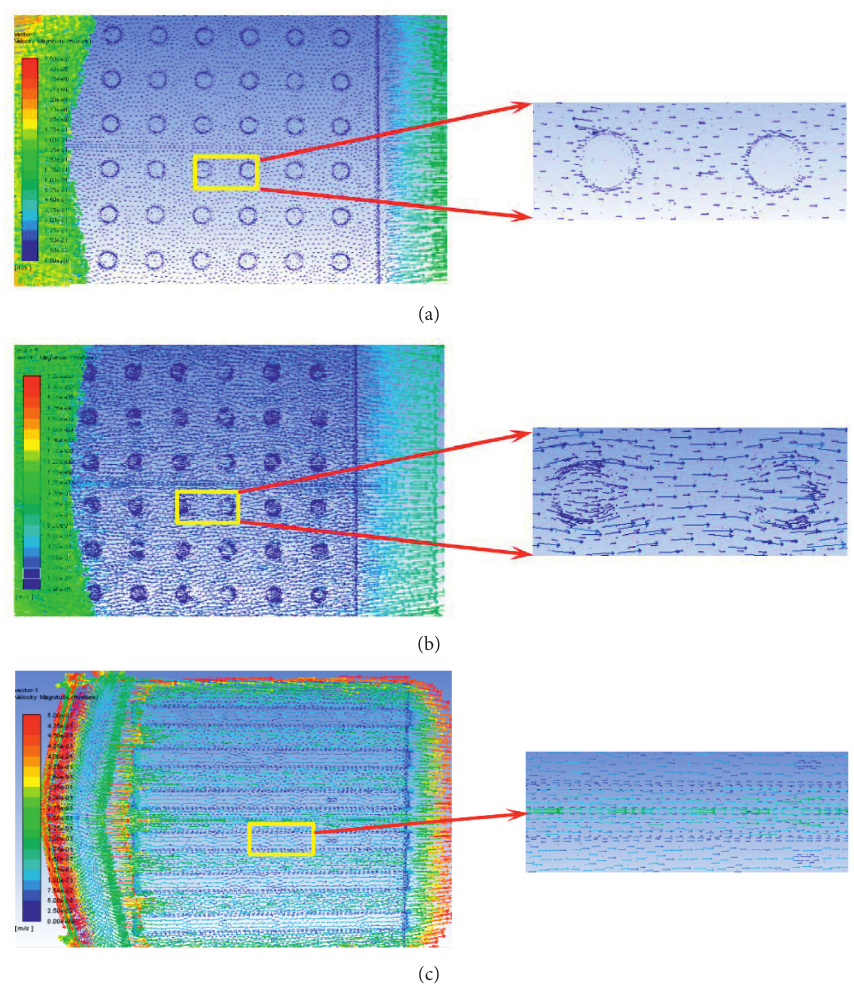
Figure 15: Streamline diagram of different bottom structures: (a) Velocity distribution and partial enlargement diagram of concave envelope at 365mm. (b) Velocity distribution and partial enlargement diagram of convex hull at 365mm. (c) Velocity distribution and partial enlargement diagram of groove at 365mm (enlarged as groove superficial